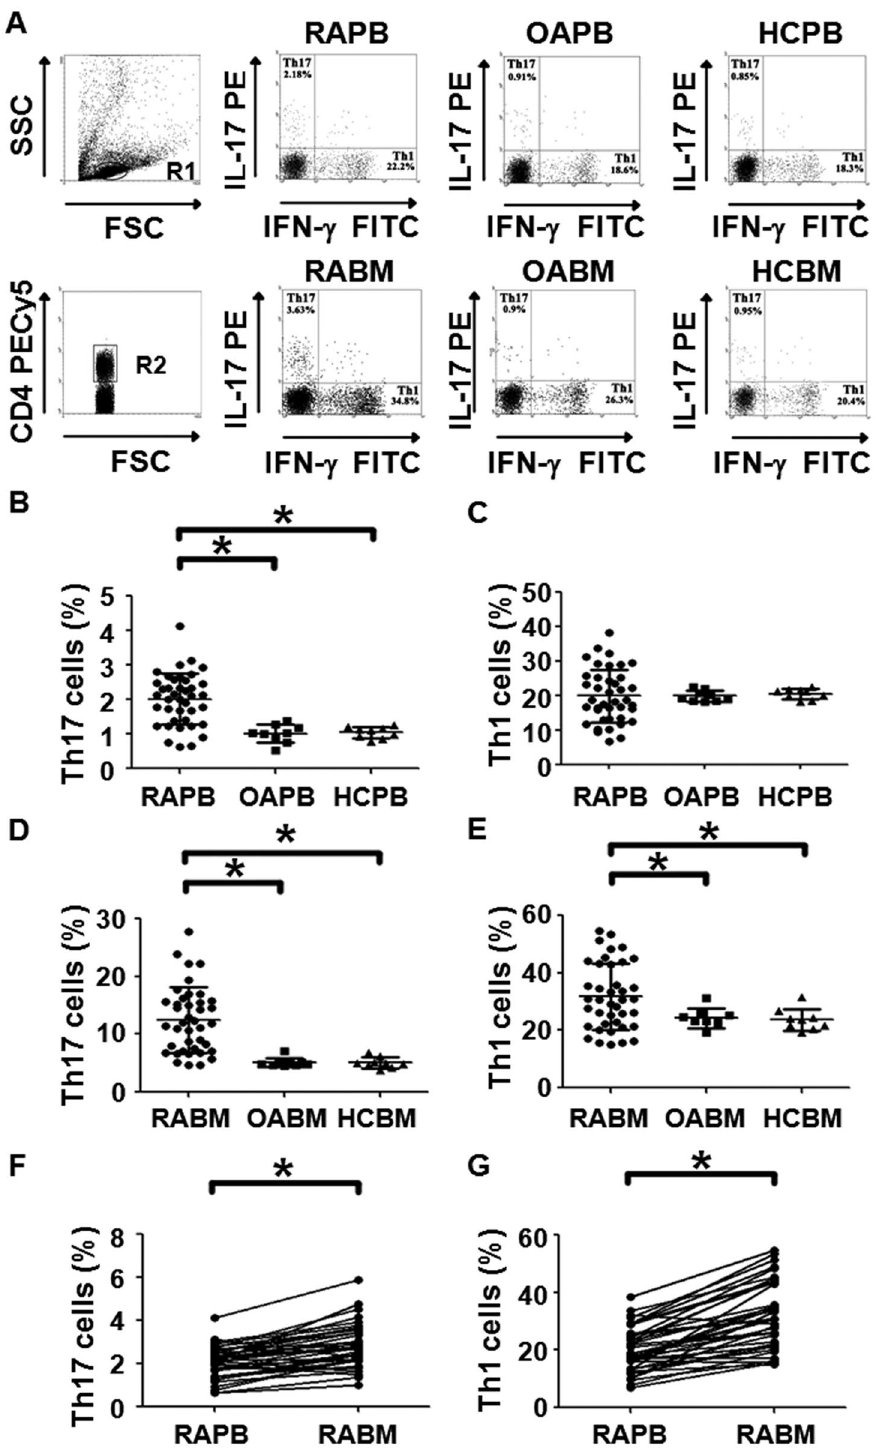
Figure 2. Frequencies of Th17 and Th1. ( A ) Flow cytometry for the detection of the frequencies of Th17 and Th1. ( B ) The percentage of Th17 in peripheral blood from rheumatoid arthritis patients (RAPB), osteoarthritis patients(OAPB) and healthy controls (HCPB). ( C ) The percentage of Th1 in peripheral blood from rheumatoid arthritis patients (RAPB), osteoarthritis patients(OAPB) and healthy controls (HCPB). ( D ) The percentages of Th17 in bone marrow blood from rheumatoid arthritis patients (RABM), osteoarthritis patients(OABM) and healthy controls (HCBM). ( E ) The percentages of Th1 in bone marrow blood from rheumatoid arthritis patients (RABM), osteoarthritis patients(OABM) and healthy controls (HCBM). ( F ) The percentages of Th17 in peripheral blood (RAPB) and bone marrow blood (RABM) from rheumatoid arthritis patients. ( G ) The percentages of Th1 in peripheral blood (RAPB) and bone marrow blood (RABM) from rheumatoid arthritis patients. * P <